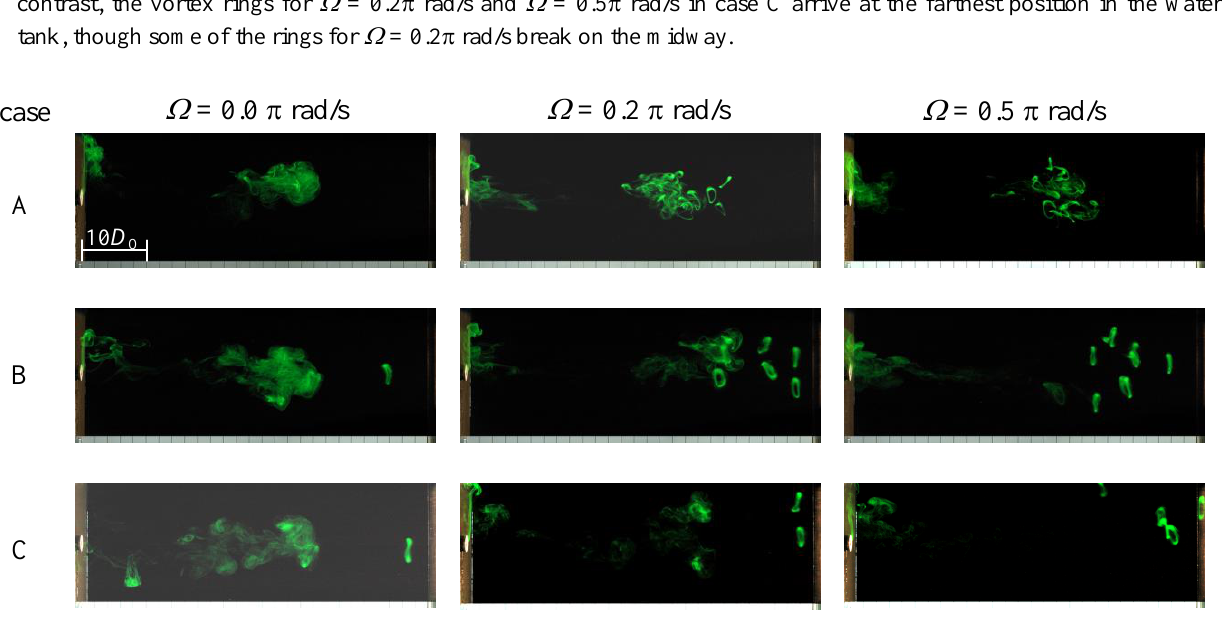
Fig. 6 Fluid distribution transported by vortex rings with/without swirl at t * = 80 s in all